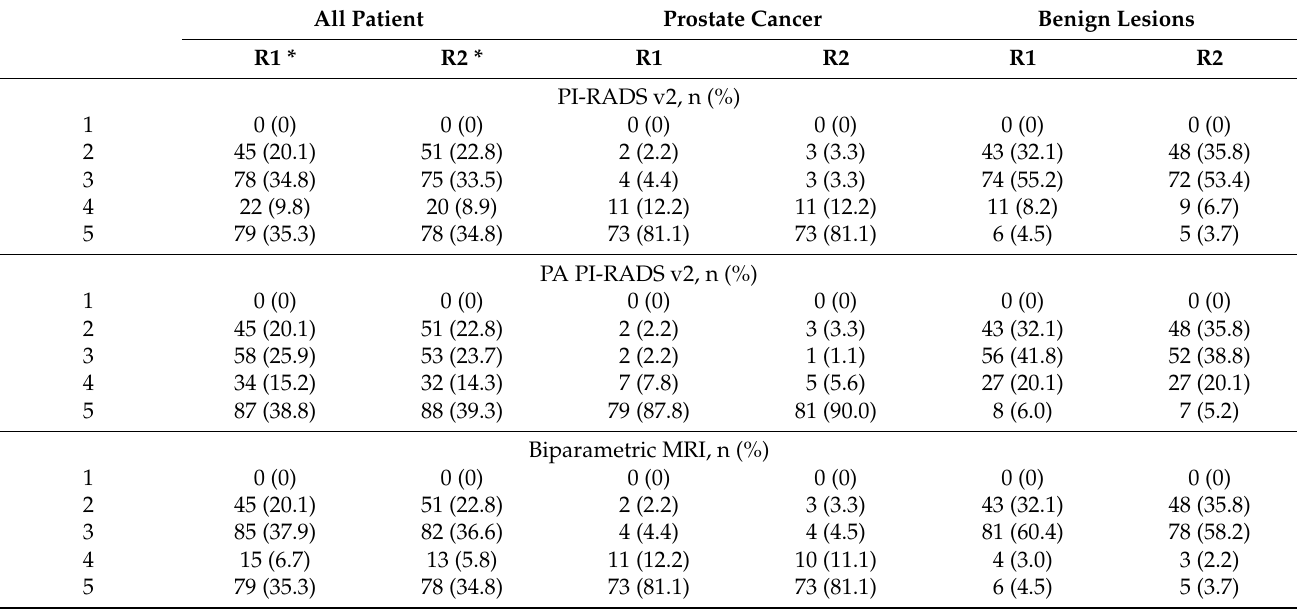
Table 5. PI-RADS assessments of the three protocols by the two